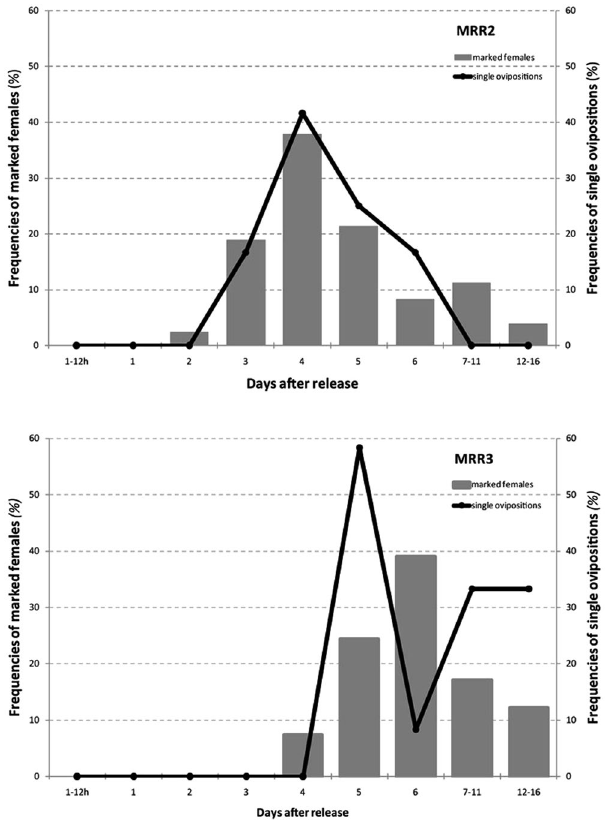
Figure 4. Frequencies of marked Aedes albopictus females collected (grey bar) in the second (MRR2, ( A ) and third (MRR3, ( B ) mark-release-recapture experiment versus frequencies of ovipositing females kept in semi- natural conditions (single ovipositions, black line) during the same